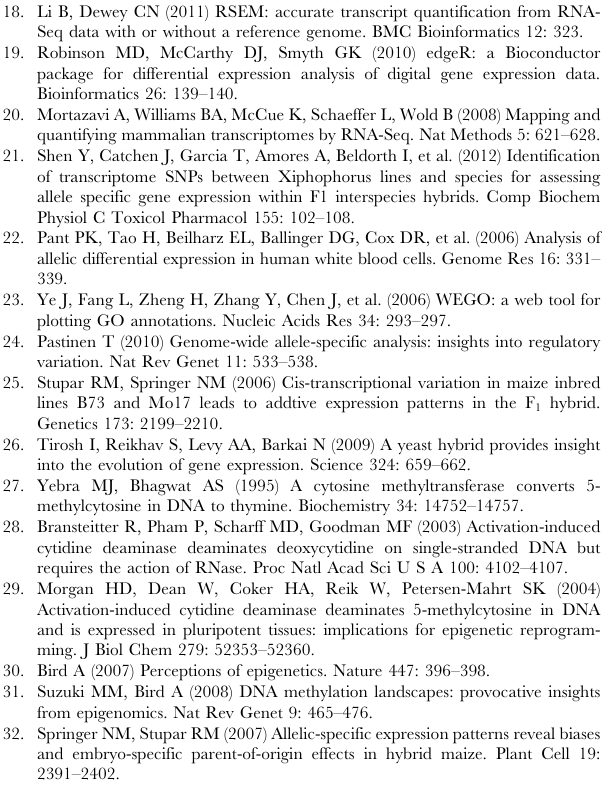
Table S2 SNPs showing consistent allelic expression biases in the hybrid. Table S3 SNPs showing significant allelic biases for accumulated transcripts in the hybrid at the tillering stage. Table S4 SNPs showing significant allelic biases for accumulated transcripts in the hybrid at the heading stage. Table S5 Thirty-eight transcripts showing biases to- wards one parental allele in the F 1